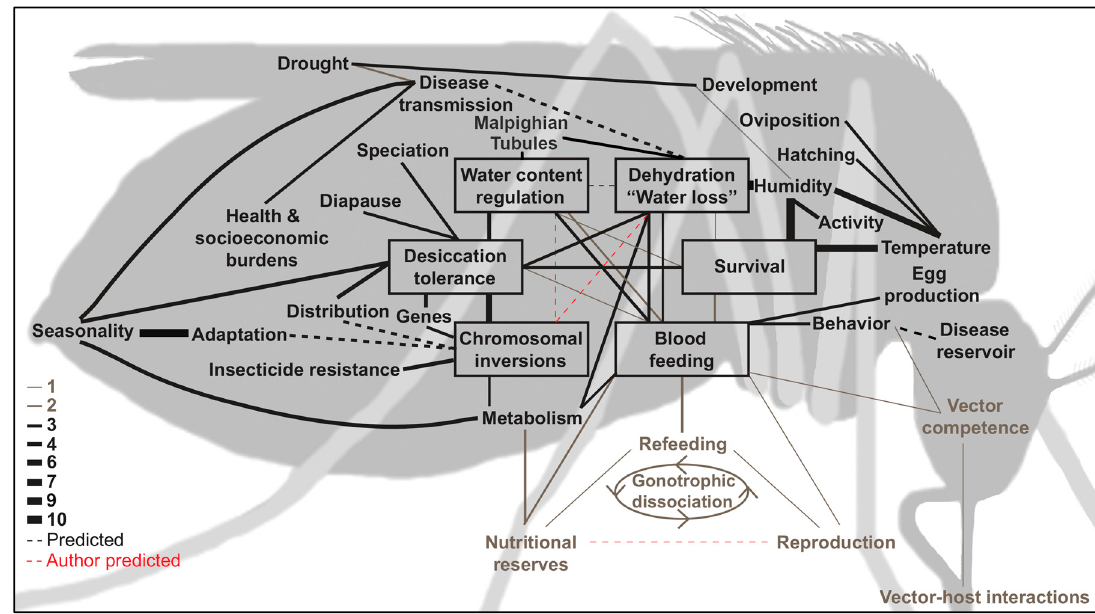
Figure 1. Concept mapping of factors integral to the dehydration of mosquitoes. Black line color signifies published support from three or more articles; grey, two or less articles; and, red, associations proposed in this review article. Solid lines denote at least one known association connecting two terms, dashed lines denote predicted associations from this publication (“Author predicted”) as well as predictions from other publications (“Predicted”). Line thickness is directly associated with the number of publications discussing connection of two terms. Associations are causal and supported by three or more publications, specific reference numbers are enumerated in Table S1. Connections with support from two or less publications are included to emphasize associations that are likely important to the holistic impact of dehydration on mosquito-borne disease transmission. A full account of associations is given in Table S2.